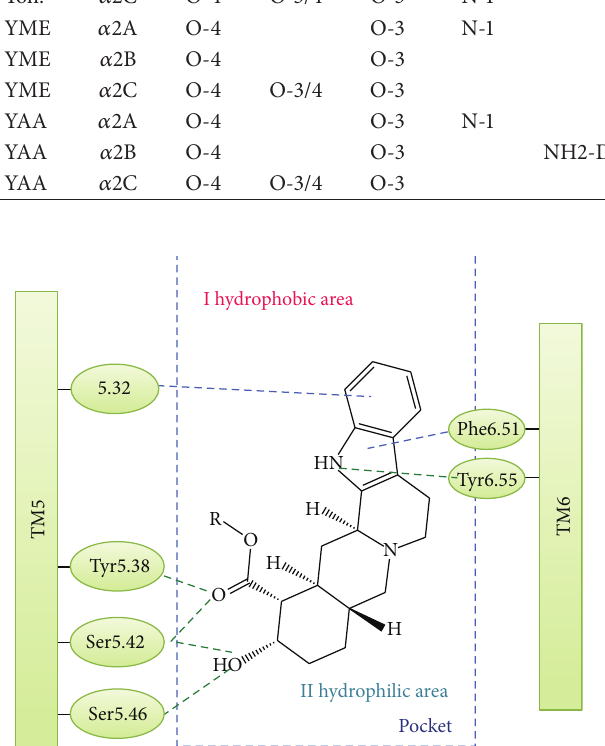
Figure 8: The 2 compartments binding modes for yohimbine and its